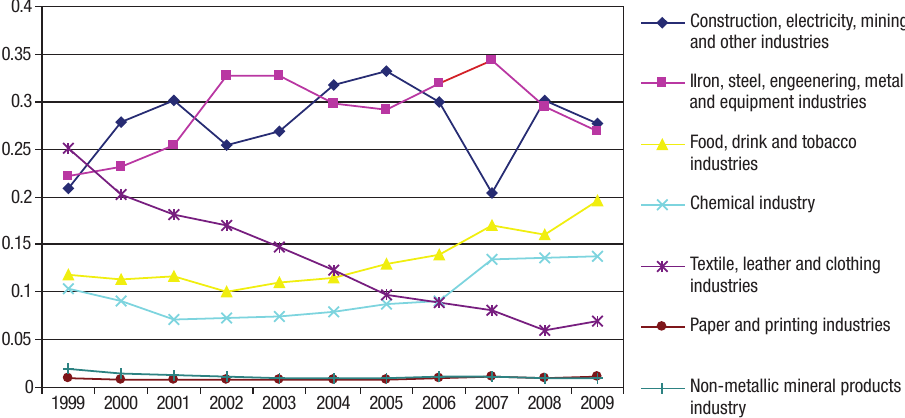
Fig. 3. Lithuania’s export during the 1999–2009 period refl ected by share of overall industrial sector’s export,